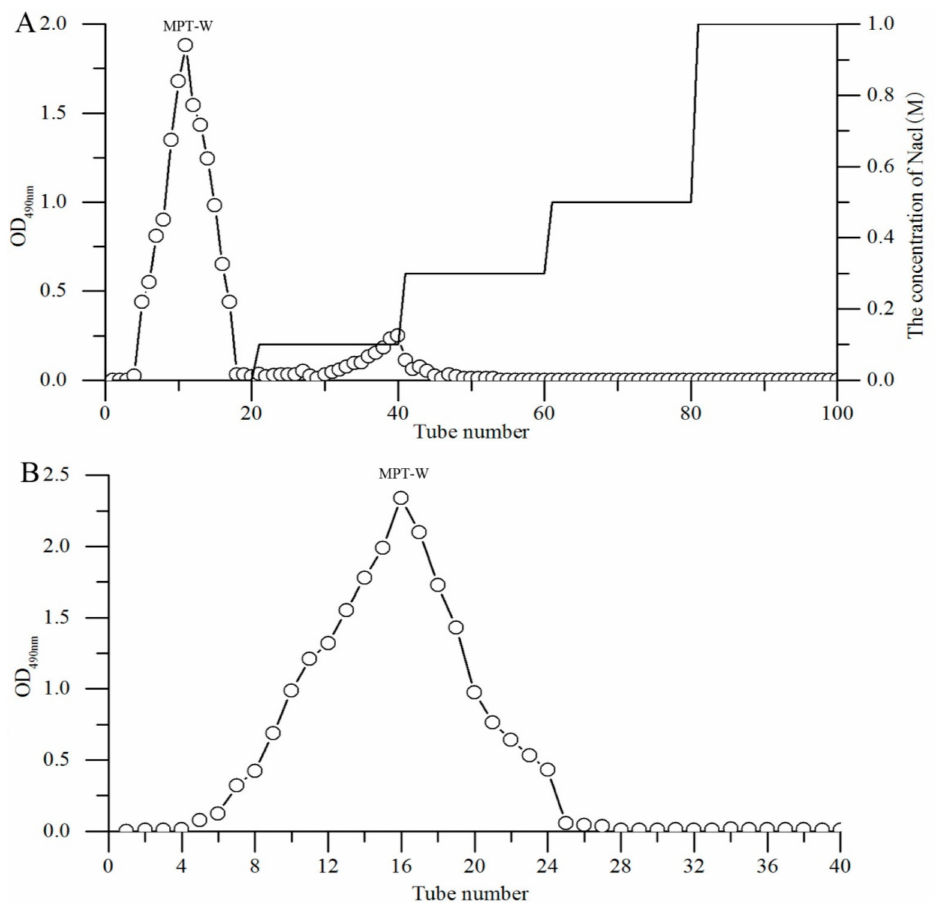
Figure 1. Elution profile of Termitomyces albuminosus (MPT). ( A ) DEAE-52 cellulose column chromatography; ( B ) Sephadex G-100 column